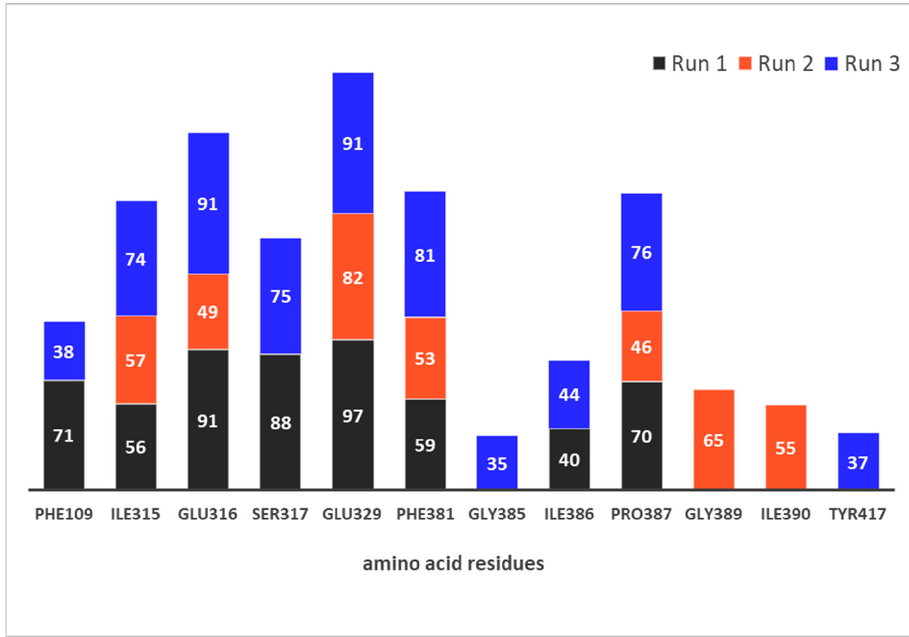
Figure 9. Native contacts between hDPP III residues and compound 12 with relative occupancy of more than 30% during 300 ns MD simulations.